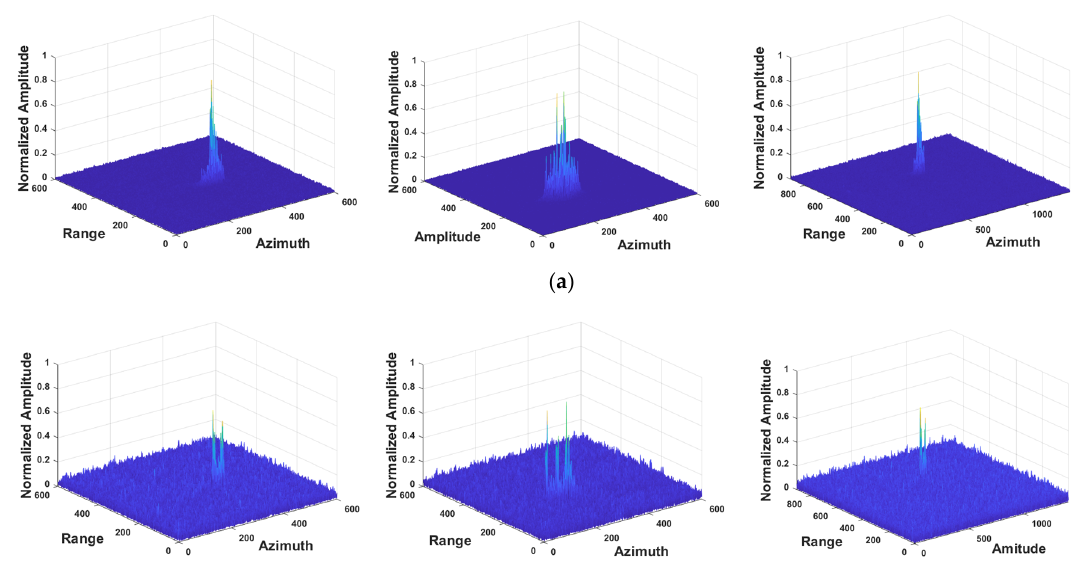
Figure 10. ( a ) Histogram of the reflection symmetry metric of Figure 4c and the GEV distribution curve; ( b ) curve shows the relationship between false alarm rate and threshold.